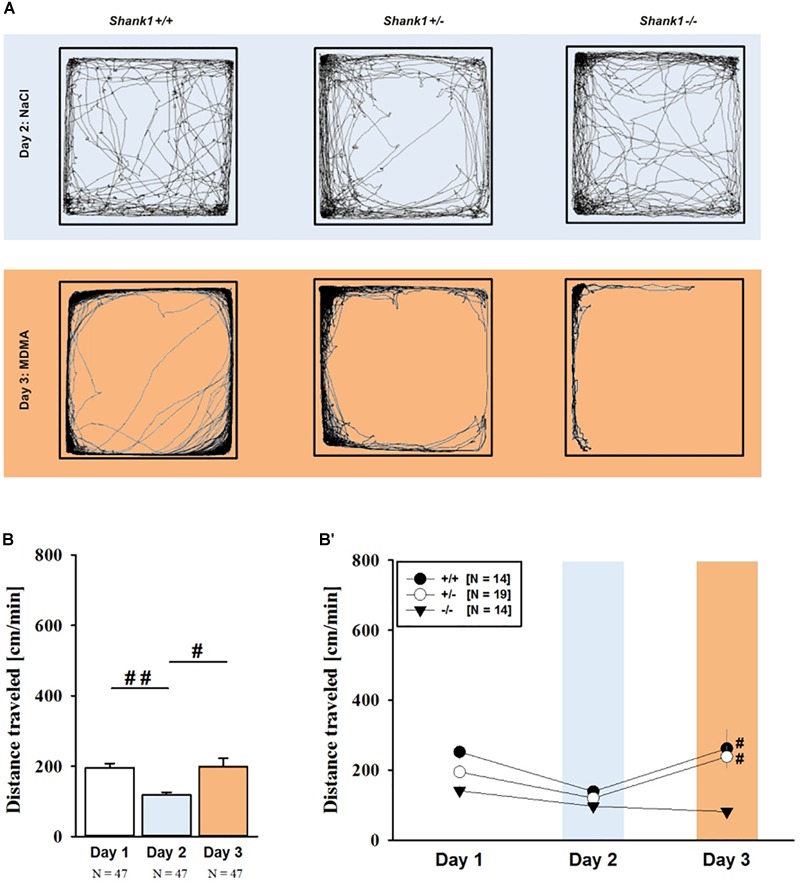
MDMA-induced hyperactivity in adult Shank1 mice. (A) Exemplary figure depicting the locomotor activity pattern of individual adult Shank1+/+, Shank1+/-, and Shank1-/- mice injected with saline (NaCl) on day 2 (upper panel) and with MDMA on day 3 (lower panel); measured over 45 min. (B) Bar graph depicting the distance traveled by all genotypes during baseline testing (white bar), following saline administration (blue bar), and after MDMA treatment (orange bar). (B′) Line graph depicting the distance traveled by Shank1+/+ (black circle), Shank1+/- (white circle), and Shank1-/- (black triangle) over the three consecutive test days. Data are presented as means + SEM or means ± SEM. #p < 0.05, ##p < 0.001 (B), #p < 0.05 vs. day 2 (B′).